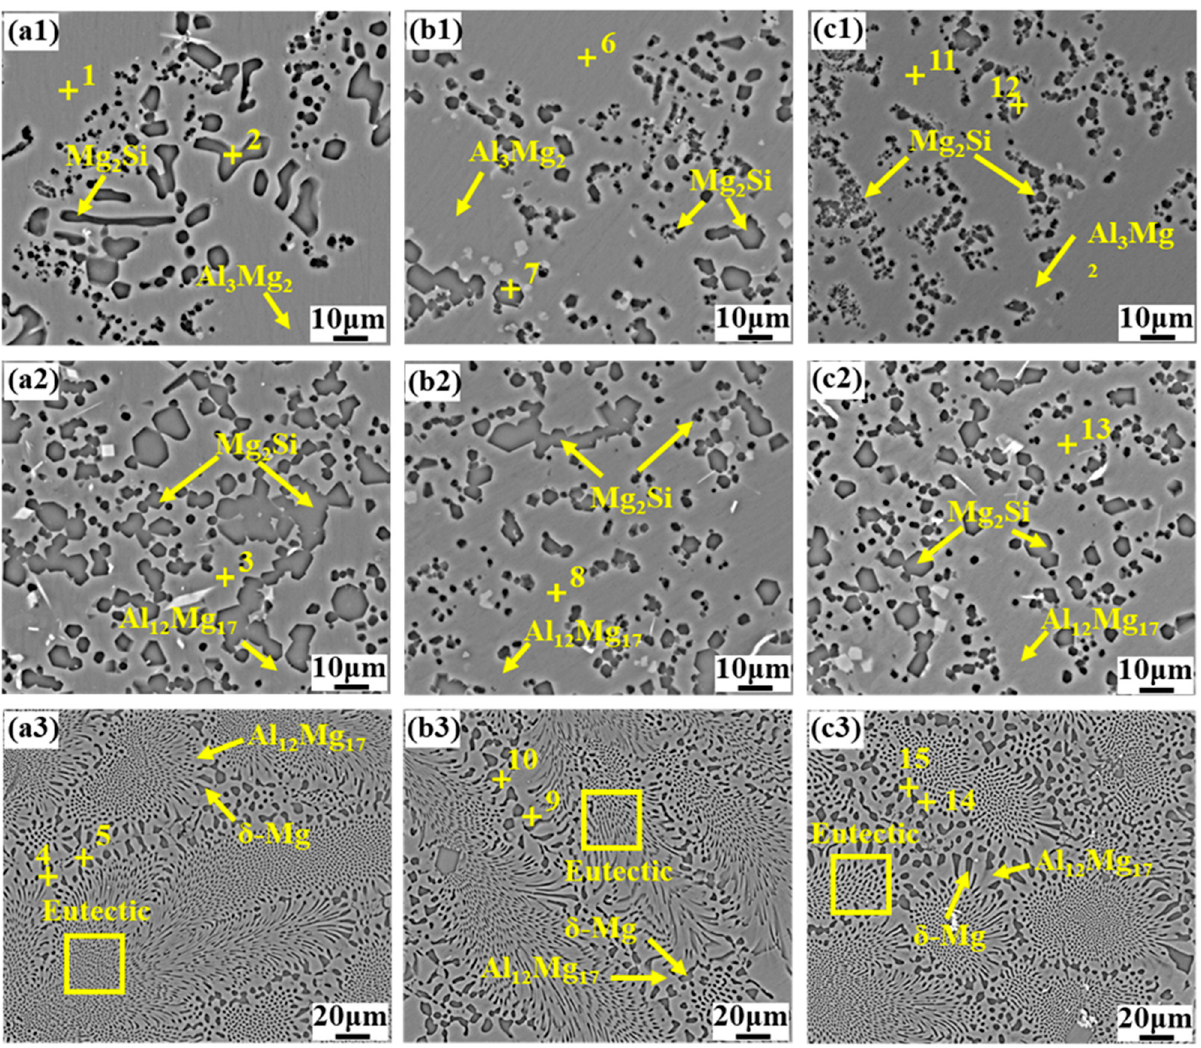
Figure 4. Microstructures of the Mg–Al bimetals obtained with different conditions: ( a ) without vibration; ( b ) with the vibration acceleration of 0.3 g; ( c ) with the vibration acceleration of 0.9 g; ( a1 – a3 ) microstructures under high magnification in the regions a1–a3 in ( a ), respectively; ( b1 – b3 ) microstructures under high magnification in the regions b1–b3 in ( b ), respectively; ( c1 – c3 ) microstructures under high magnification in the regions c1–c3 in ( c ), respectively.